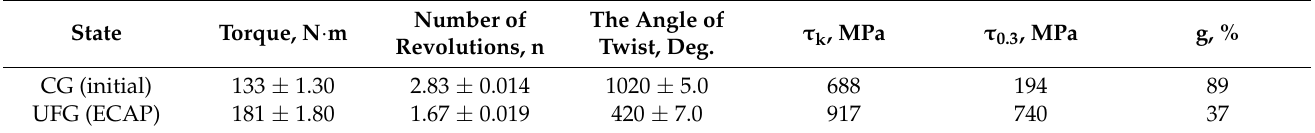
Figure 3. “Torque—angle of twist” diagram based on the torsion tests of the specimens from the CG ( 1 ) and UFG ( 2 ) steel. Table 4. Mechanical properties of the steel.